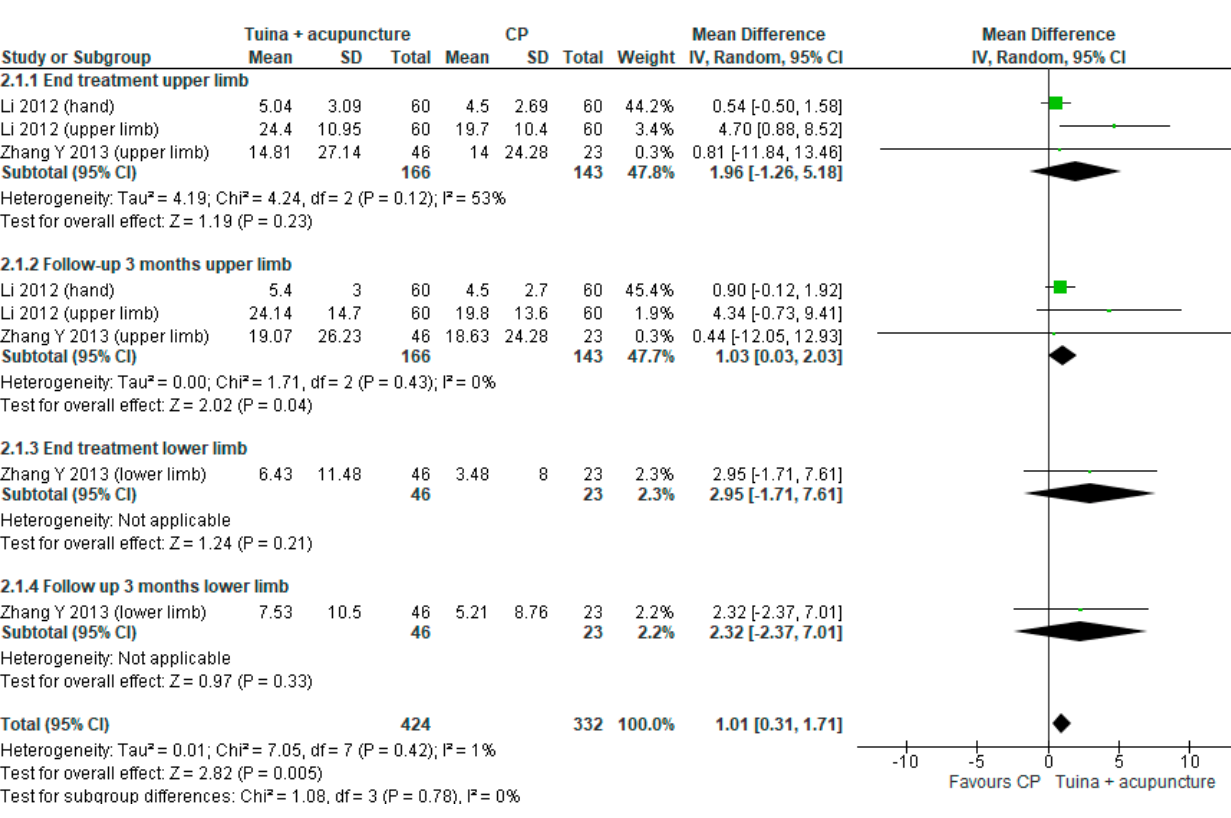
Figure 3. Forest plot of comparison Tuina massage plus conventional physiotherapy (CP) versus CP for upper limb motor function in subacute stage ( ≤ 3 months) evaluated by Fugl Meyer Assessment.